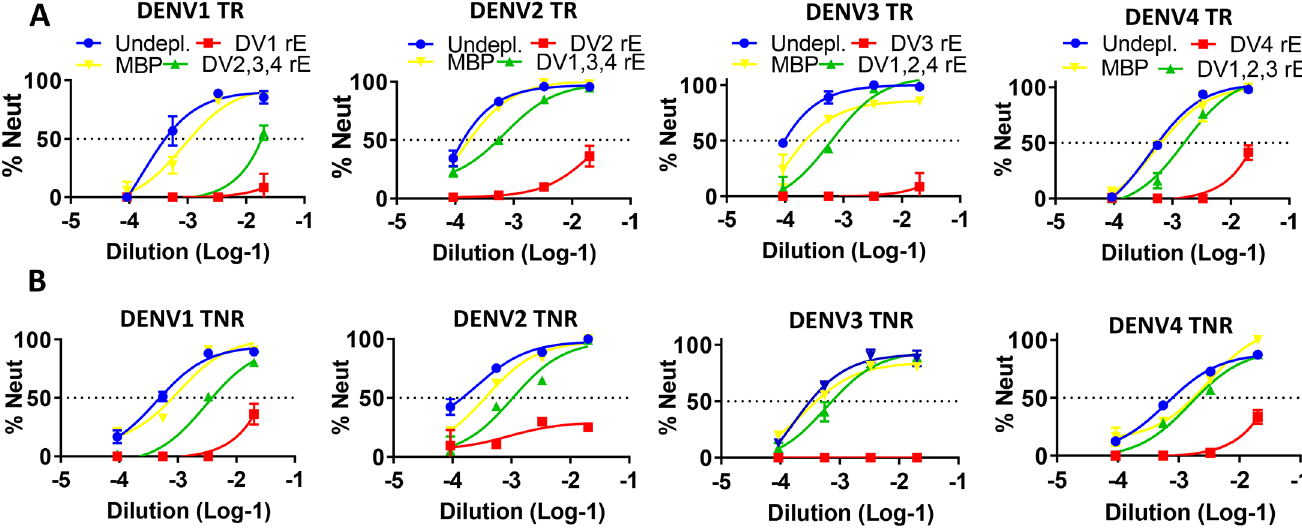
Fig 7. DENV rE particulation enhances serotype specificity in tetravalent formulations. To determine the portion of serotype-specific neutralizing antibodies, sera from A) TR and B) TNR immunized mice were depleted from serotype-specific and cross-reactive (red lines), cross-reactive (green lines) neutralizing antibodies. Serum neutralization was determined using a flow based approach where serially diluted serum was incubated with virus, which was subsequently allowed to infect vero-cells. Neutralizing capacity of the sera is expressed as Neut 50 values, indicating the serum dilution where 50% of the virus is neutralized ( Table 1